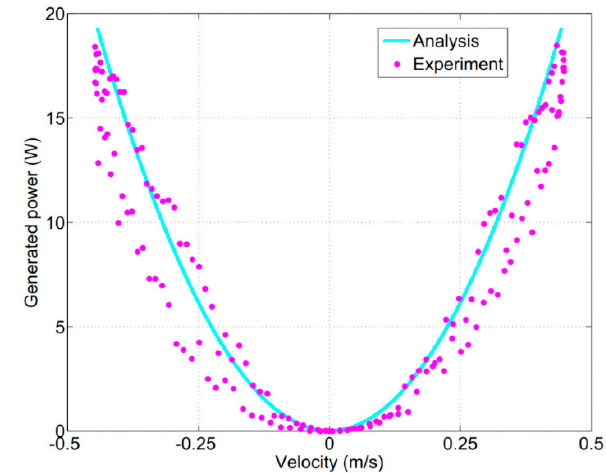
Figure 14. Comparison between the simulation and experimental results of the generated power under 2.4 Hz frequency and 30 mm amplitude.